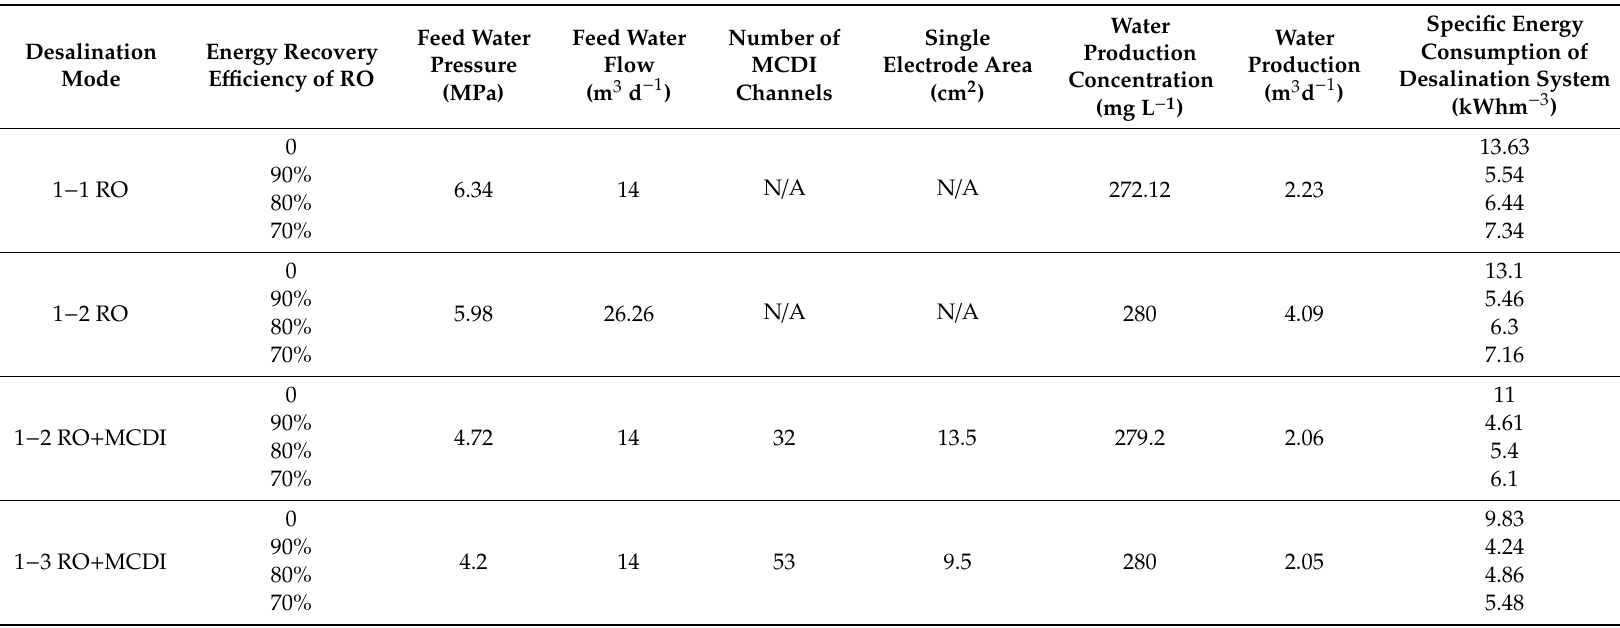
Table 3. Comparison of optimization